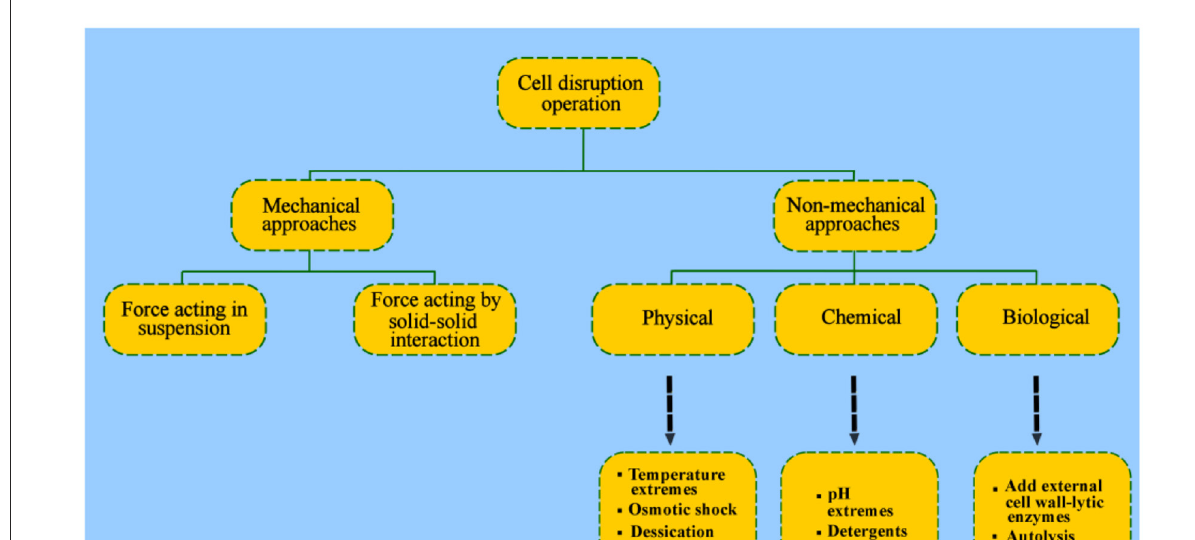
FIGURE5 Antimicrobial mechanism by promoting cell wall disruption and lysis (Moo-Young, 2019).